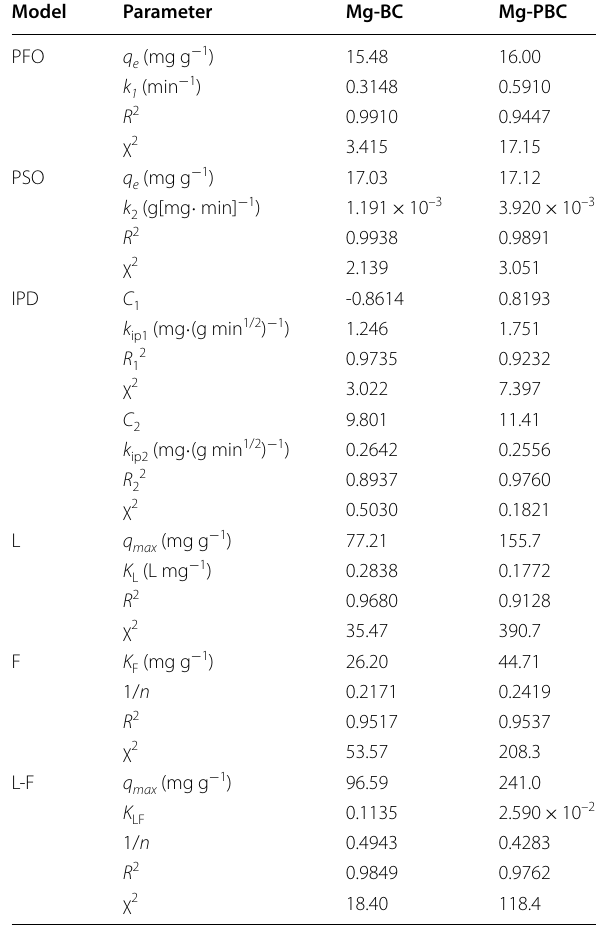
Table 2 Obtained parameters of P adsorptive recovery kinetics model and isotherm